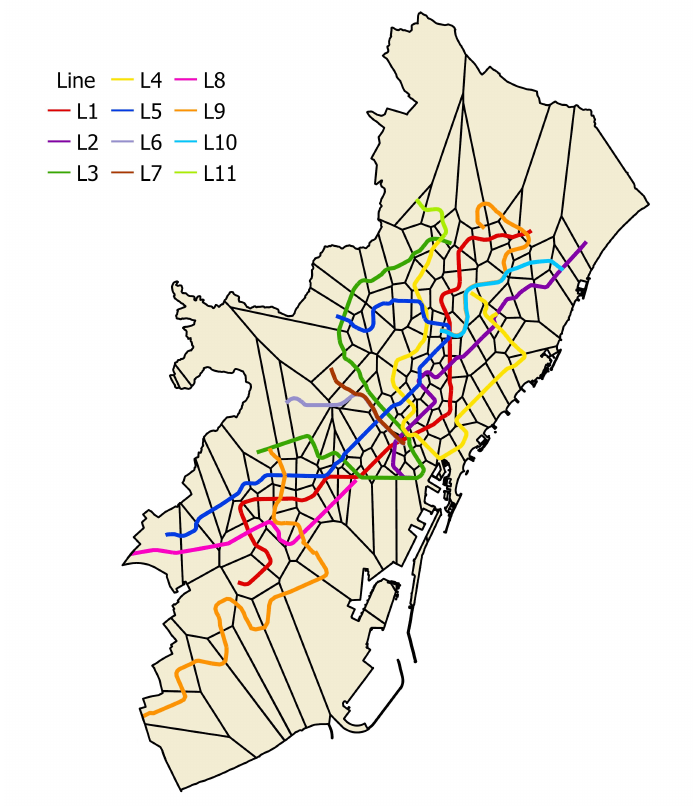
Figure 2. The 2019 Barcelona metro network.